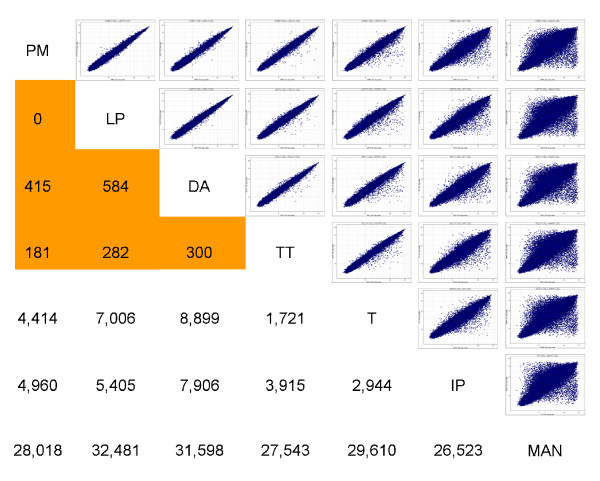
Scatter plot and statistical analysis comparing all seven stages investigated with the wheat Affymetrix GeneChip® to one another. PM = pre-meiosis; LP = leptotene to pachytene; DA = diplotene to anaphase I; TT = telophase I to telophase II; T = tetrads; IP = immature pollen; MAN = mature anthers. All values in the figure represent the number of transcripts with corrected p-values ≤ 0.05 from t-tests performed between the two tissues of interest. The orange shading represents the pooled stages from where the 1,350 non-redundant meiotically-regulated transcripts were identified.